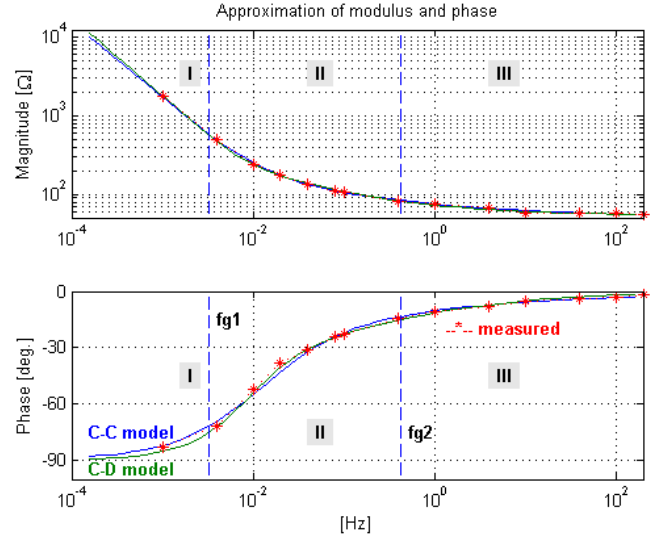
Figure 2. The approximation of the measured frequency response of 0.1F supercapacitor (asterisks) by the fractional order transfer function based on the Cole–Cole and Cole–Davidson models (WII = 120).